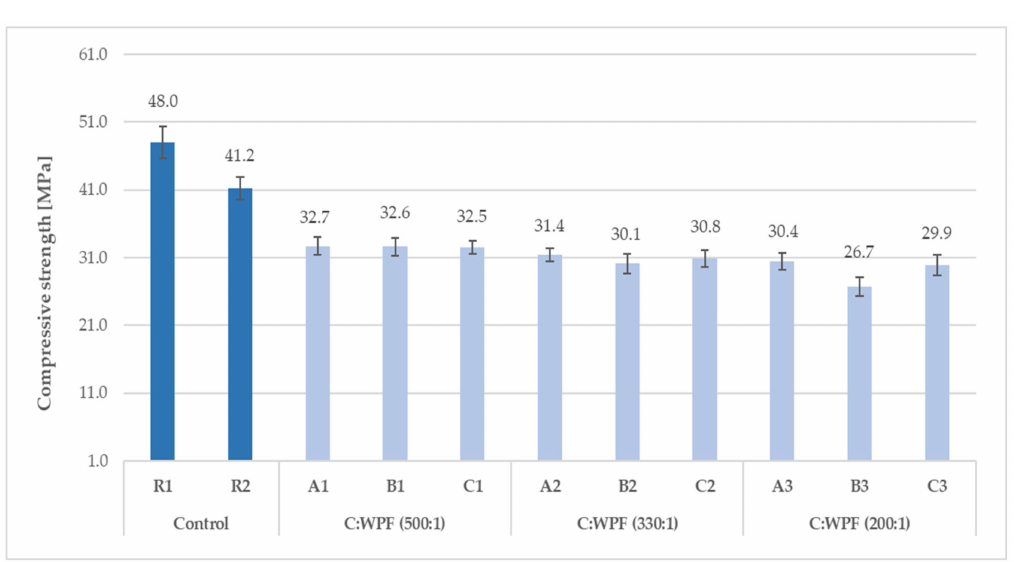
Figure 15. Compressive strength of fiber-cement mortars with different C/WPF ratios (set I).